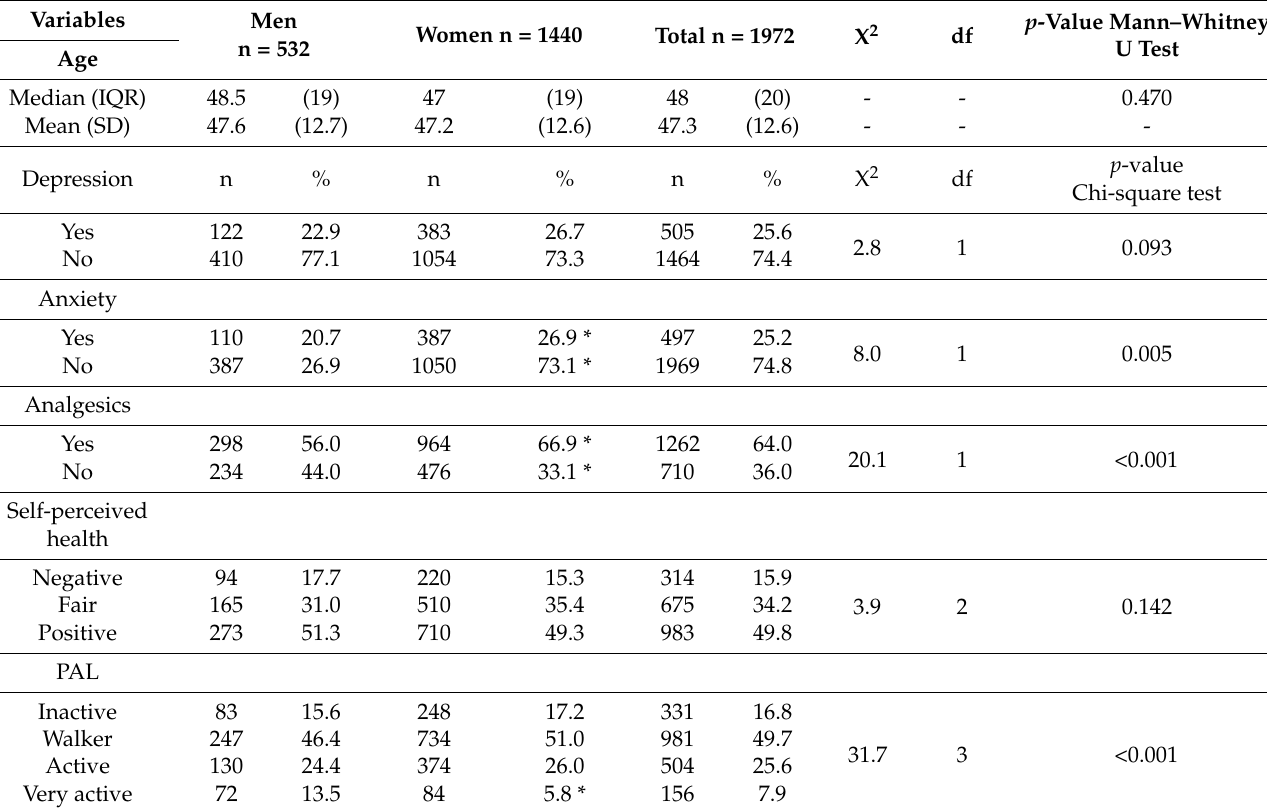
Table 3. Descriptive analysis of the migraine population: age, depression, anxiety, analgesics, self- perceived health, and level of physical activity. Comparison between sexes and analysis of the dependence between the categorical variables and the sex of the participants.